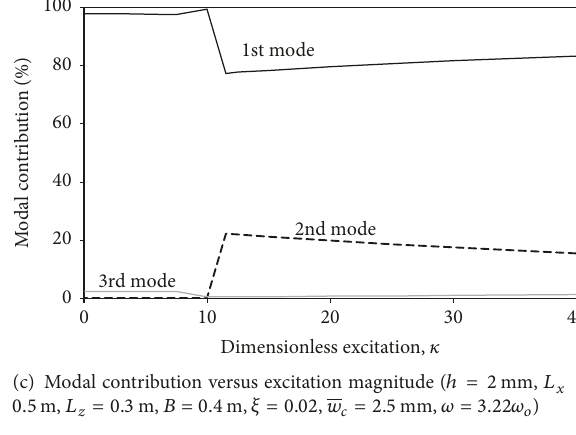
(a) Modal contribution versus excitation magnitude ( ℎ = 2 mm, 𝐿 𝑥 = 0.5 m, 𝐿 𝑧 = 0.3 m, 𝐵 = 0.4 m, 𝜉 = 0.02 , 𝑤 𝑐 = mm, 𝜔 = 0.805𝜔 𝑜 )